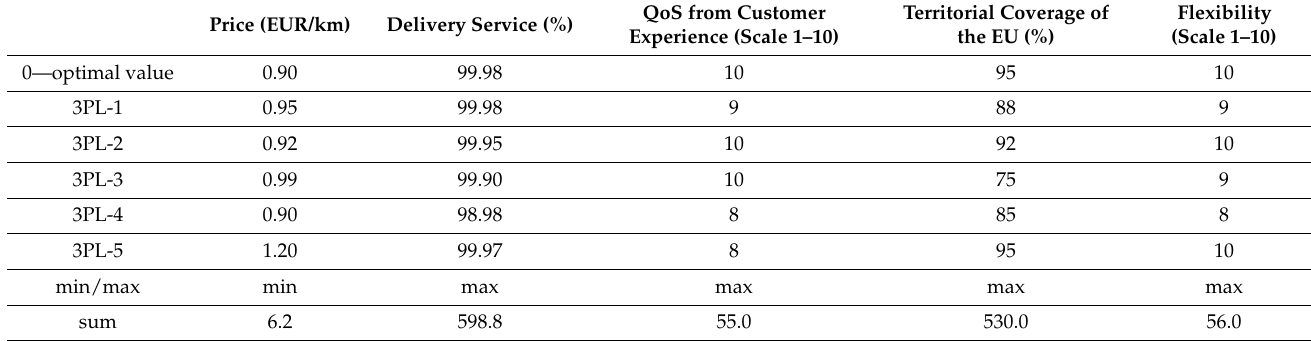
Table 11. Initial ARAS decision-making matrix (Source: Authors).